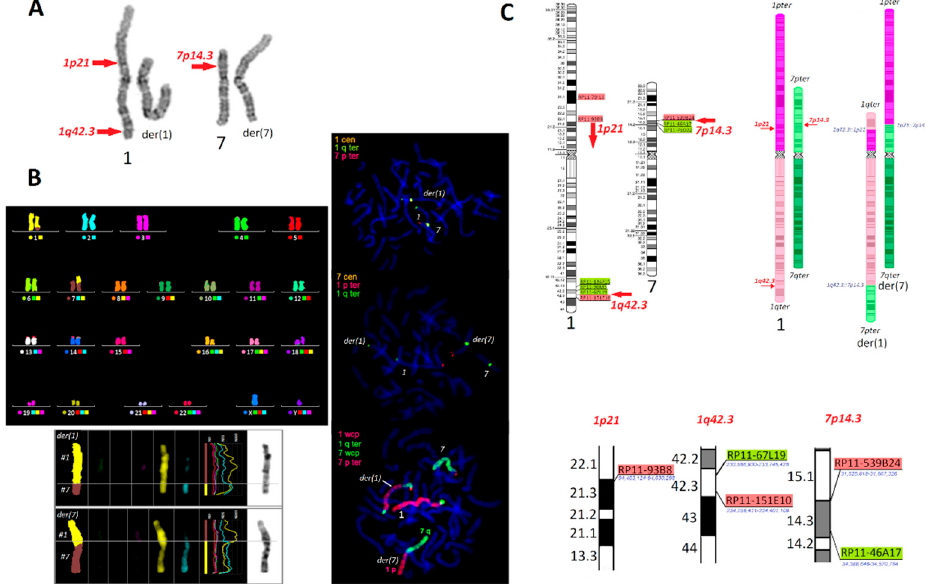
Figure 1. The characteristics of the chromosomes involved in complex chromosomal rearrangements (CCRs) t(1;7). ( A ) G-banding using trypsin and Giemsa staining (GTG banding) with marked breakpoints (UV–Vis microscope, Olympus BX41, magnification 1000 × , software: Ikaros MetaSystems); ( B ) fluorescent in situ hybridization (FISH) staining, including various probe combinations (specific for: centromeres (cen), subtelomeres (ter), and whole chromosomes (wcp)), and multicolor FISH (mFISH)) (fluorescent microscope Zeiss AxioImager D1, magnification 1000 × ; software: ISIS MetaSystems); ( C ) a schematic representation of the bacterial artificial chromosome (BAC)-FISH) samples used (green—normal location; red—translocated), with marked breakpoint positions (arrows).